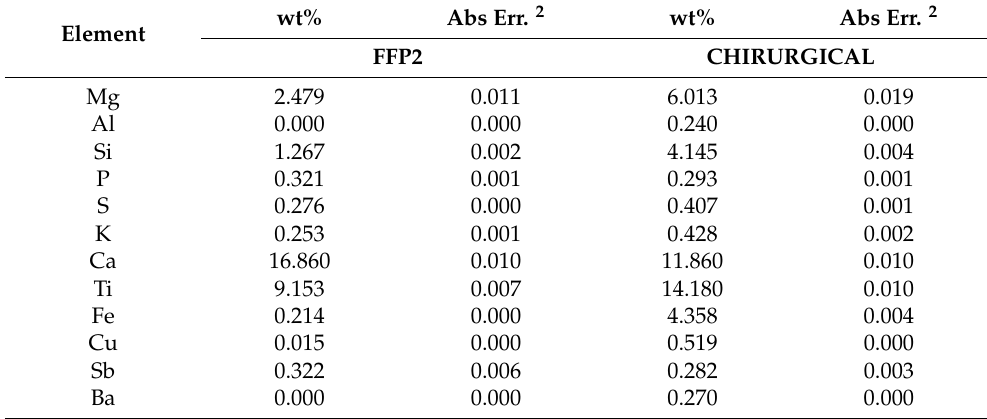
Table 5. Semi-quantitative elemental composition for FFP2 and chirurgical masks ashes via XRF.